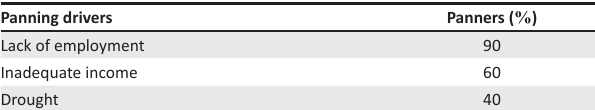
TABLE 4: Panning